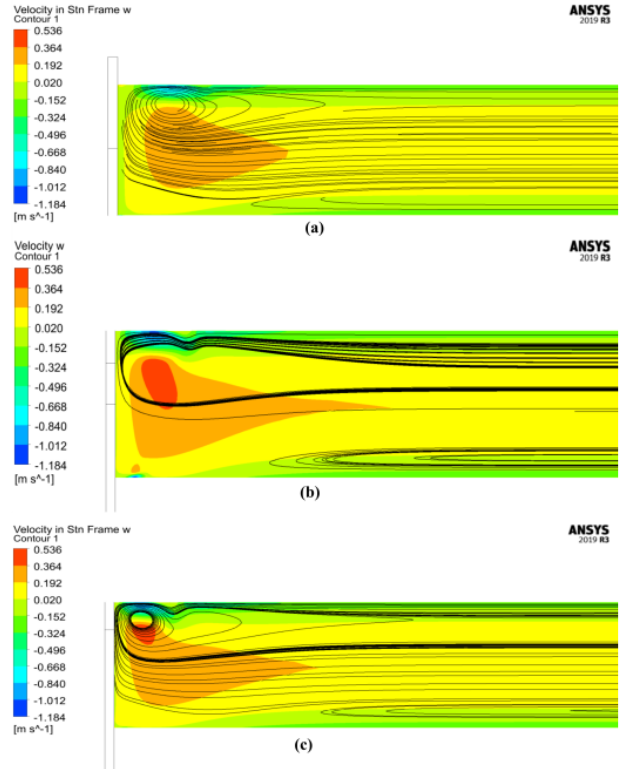
Figure 12. Streamlines and axial velocity contour of the flow inside the pipe at the end of the valve closure: ( a ) immersed solid method; ( b ) dynamic mesh; ( c ) sliding mesh.